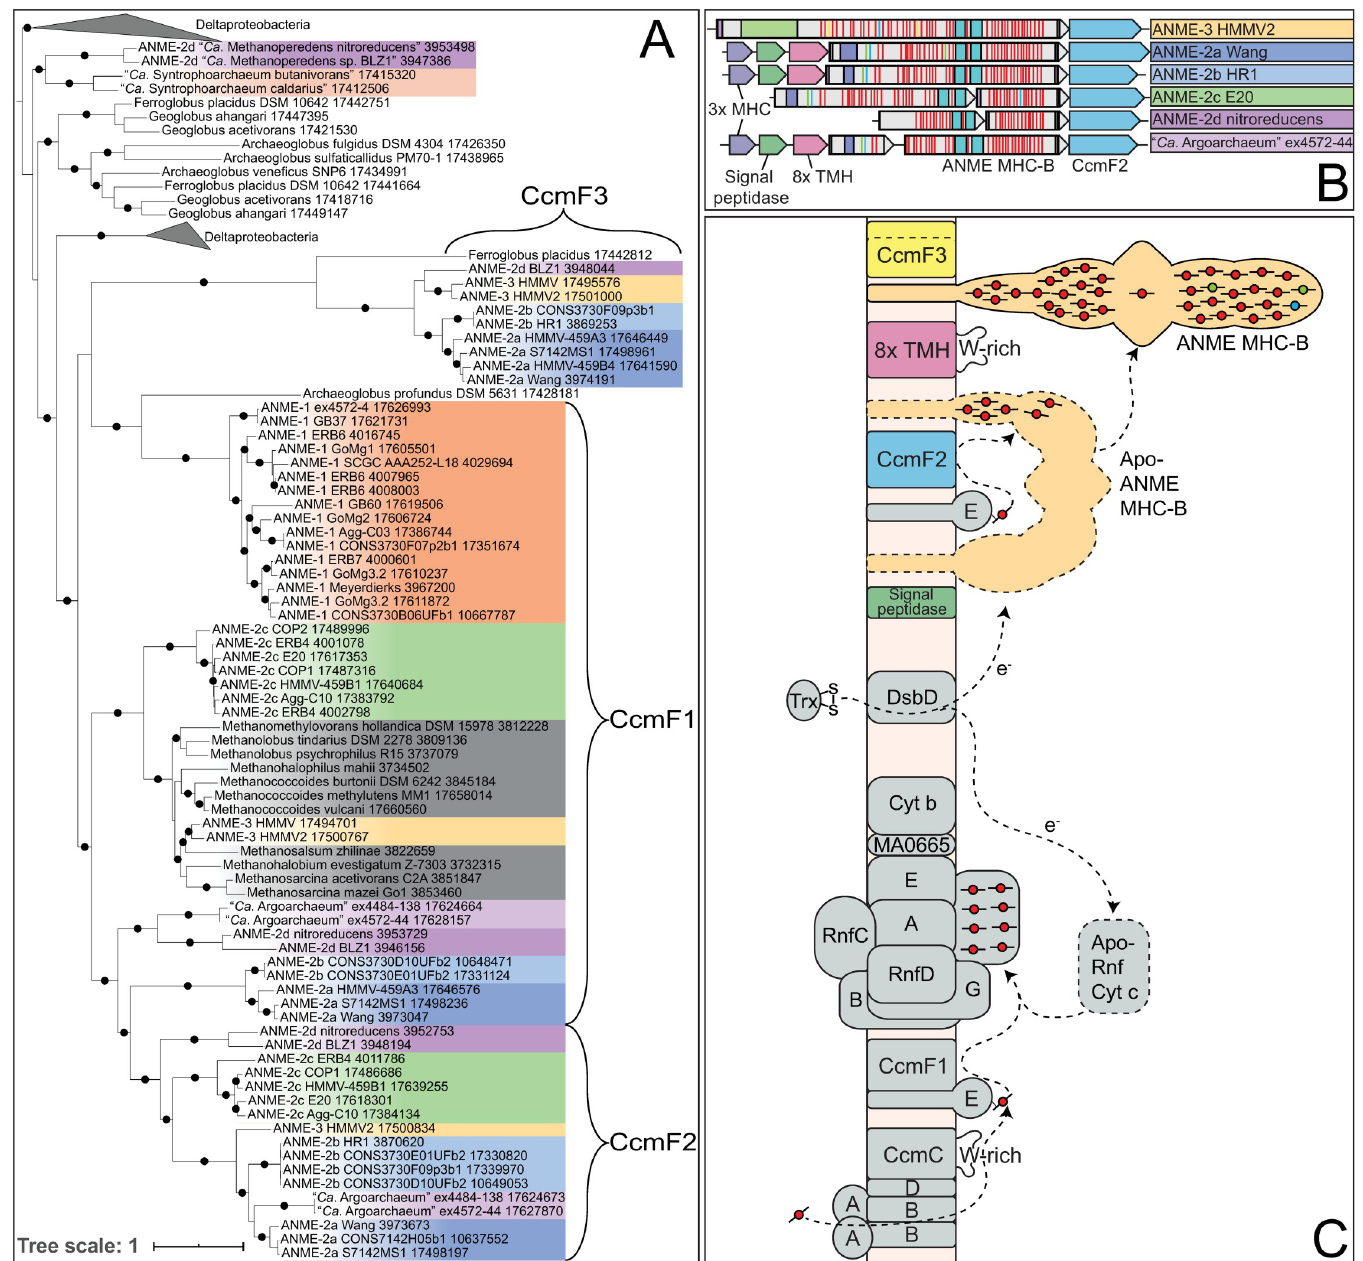
Fig 12. Cytochrome maturation and CcmF duplication. ( A ) Phylogenetic analysis of CcmF homologs from ANME and closely related archaea. CcmF1 cluster contains the CcmF found in the Methanosarcinaceae . CcmF2 is a closely related group of homologs found only in ANME and “ Ca . Argoarchaeum” and in all cases is found next to the S-layer containing ANME MHC-B. CcmF3 comprises the larger of 2 encoded genes that appear to be a split CcmF and are found in ANME and Ferroglobus . ( B ) Example gene clusters from all groups that contain CcmF2 illustrating their position with respect to ANME MHC-B. Some genomes additionally contain a signal peptidase and a predicted membrane integral ANME-specific gene in this cluster (8x TMH). Horizontal red lines denote CxxCH heme-binding domains; teal represent S- layer domain (see Fig 11 for details of ANME-MHC structure). ( C ) Schematic of cytochrome maturation pathway. CcmA and CcmB comprise ABC transporter module that exports heme B, which is transferred to CcmE via CcmC’s tryptophan (W)-rich periplasmic loop. CcmE is expected to utilize CcmF1 to mature cytochrome c proteins found in both ANME and methanogens of the Methanosarcinaceae . CcmF2, found only next to ANME MHC-B, is expected to be involved in its maturation. The co-occurring signal peptidase is likely involved in cleavage of the N-terminal signal sequence. Closed circles represent branch support values between 80% and 100%. Tree scales represent substitutions per site. Tree construction parameters are found in the Materials and methods section. Alignment and tree files can be found in S1 Data . ANME, anaerobic methanotrophic; MHC, multiheme c -type cytochrome.